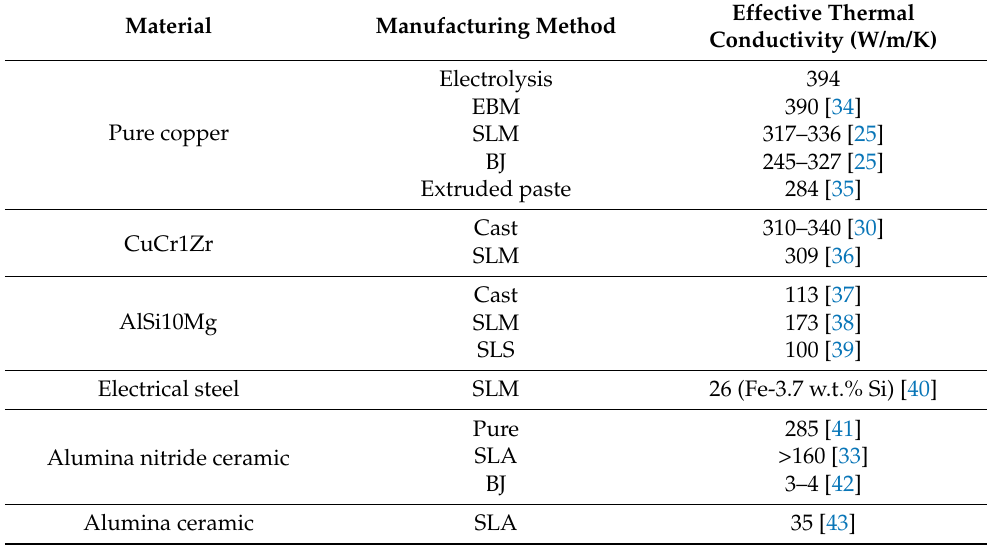
Table 1. Thermal conductivities of popular materials used in